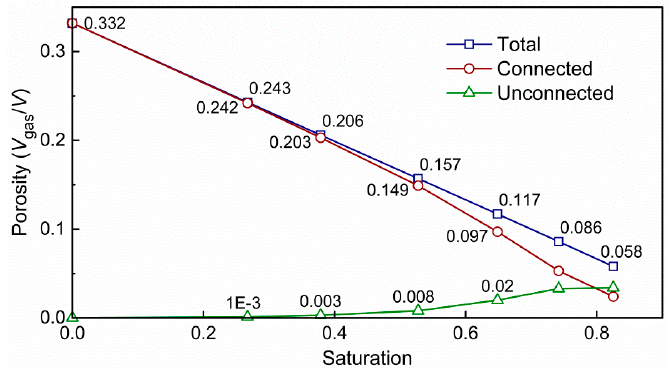
Figure 3. Changes of porosity ( V gas / V ) with water saturation. Here, porosity is the volume ratio of void voxels to the whole soil sample in Figure 1b.